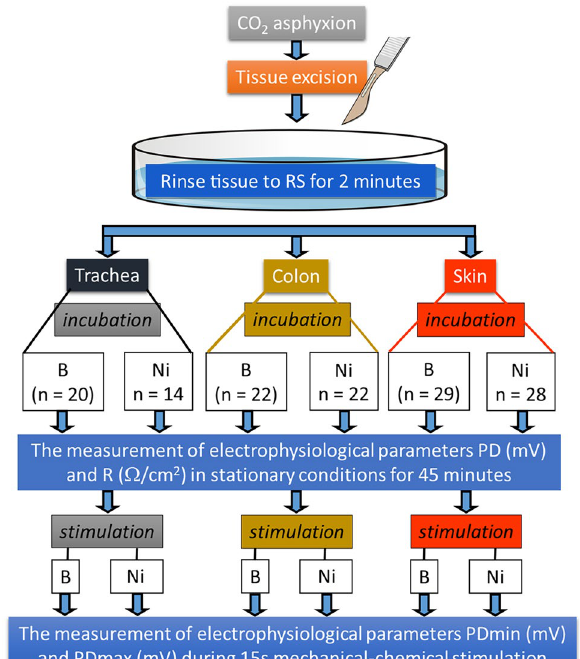
Figure 1. Study design. Abbreviations: RS—Ringer solution, B—control group incubated in bumetanide (0.1 mM) solution, Ni—nickel chloride (0.1 mM NiCl × 6 H 2 O) solution in B, PD—transepithelial potential difference of the tissue surface measured in stationary conditions (mV), PDmax—maximal transepithelial electrical potential measured during 15 s stimulation of the tissue surface (mV), PDmin—minimal transepithelial electrical potential measured during a 15 s stimulation of the tissue surface (mV), R— transepithelial electrical resistance (Ω/cm 2